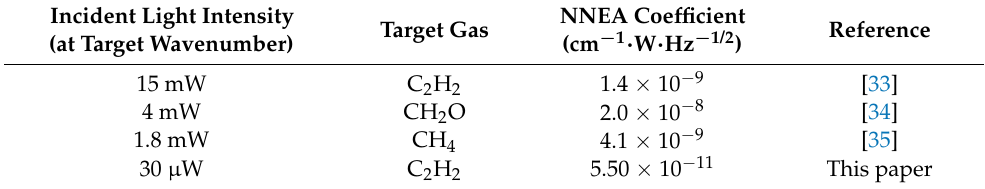
Table 2. Comparison of detection precision performance with laser-based PAS